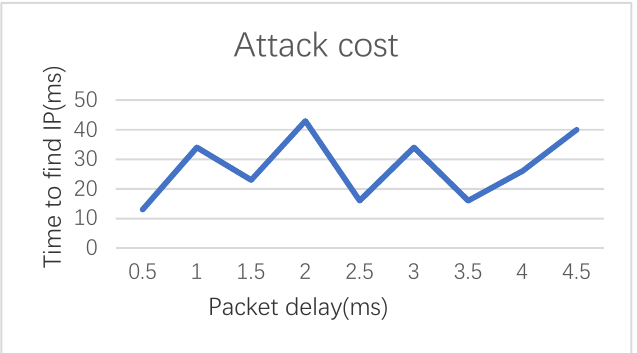
Figure 9. The overhead of realizing network reconnaissance by an attacker.